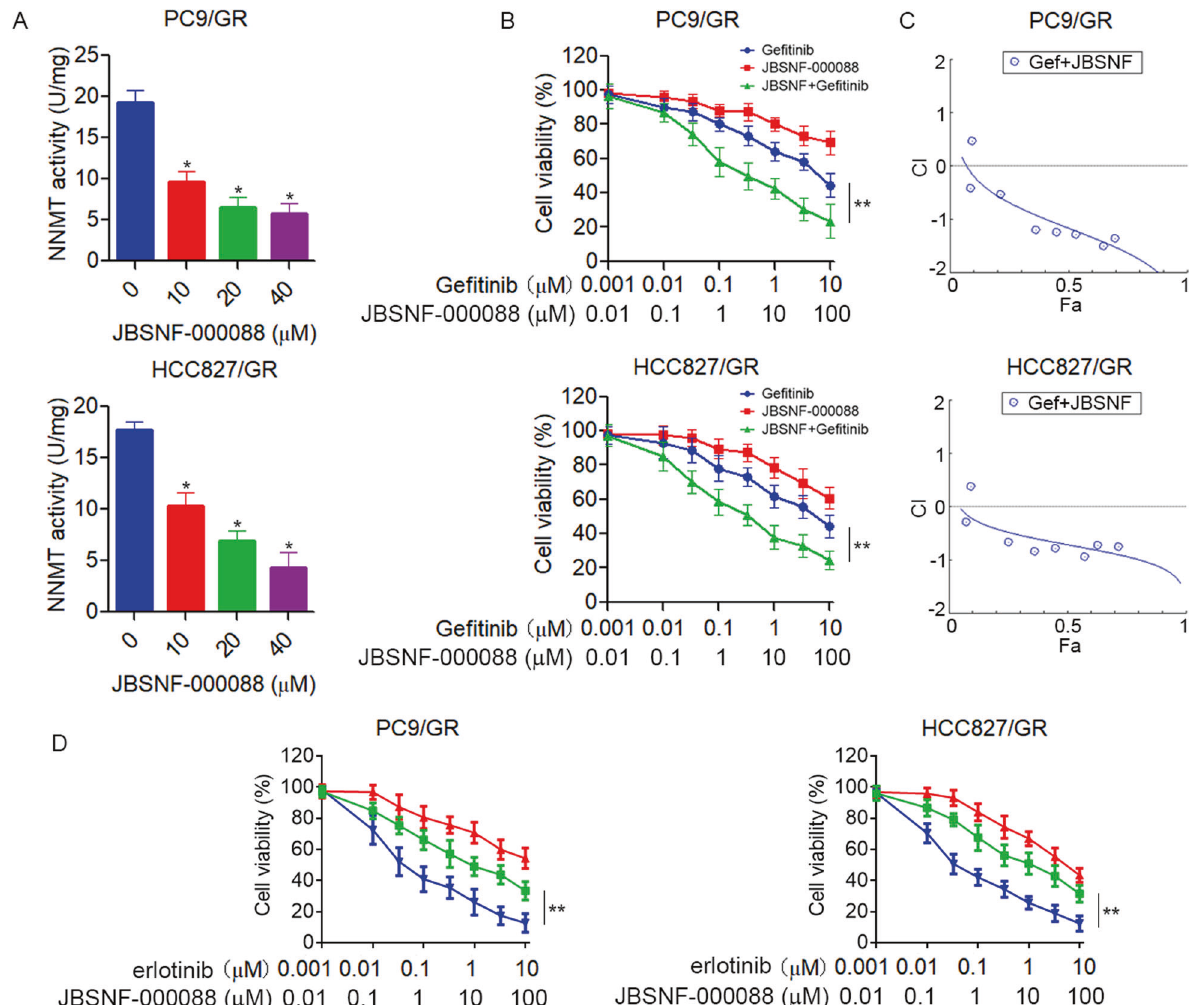
Fig. 6 Pharmacological inhibition of NNMT overcomes EGFR-TKIs resistance in NSCLC cells in vitro. A PC9/GR or HCC827/GR cells were treated with NNMT inhibitor JBSNF-000088 at the indicated concentration for 48 h, NNMT speci fi c activity was tested by measuring the amount of N 1 -methylnicotinamide produced. B PC9/GR or HCC827/GR cells were treated with ge fi tinib in combination with JBSNF-000088 at the indicated concentration for 72 h, cell viability was evaluated by MTS assay. C The combination index (CI) curves of ge fi tinib in combination with JBSNF-000088 were calculated using Calcusyn software according to the Chou – Talalay equation. D PC9/GR or HCC827/GR cells were treated with erlotinib in combination with JBSNF-000088 at the indicated concentration for 72 h, cell viability was evaluated by MTS assay. Each point represents the mean ± SD. Data show a representative of three independent experiments. (* p < 0.05, ** p <